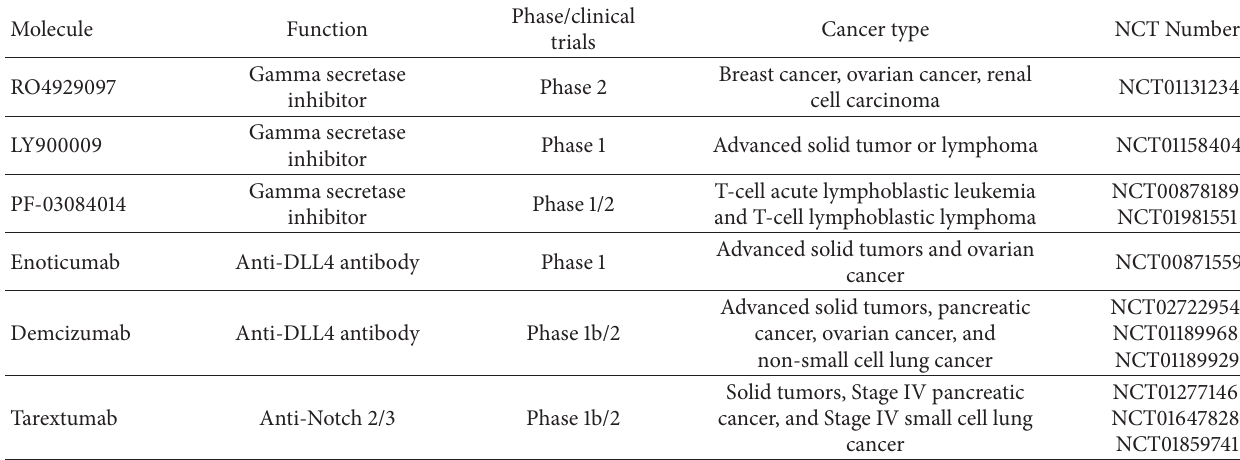
Table 3: Small molecule/biological therapeutics targeting the Notch